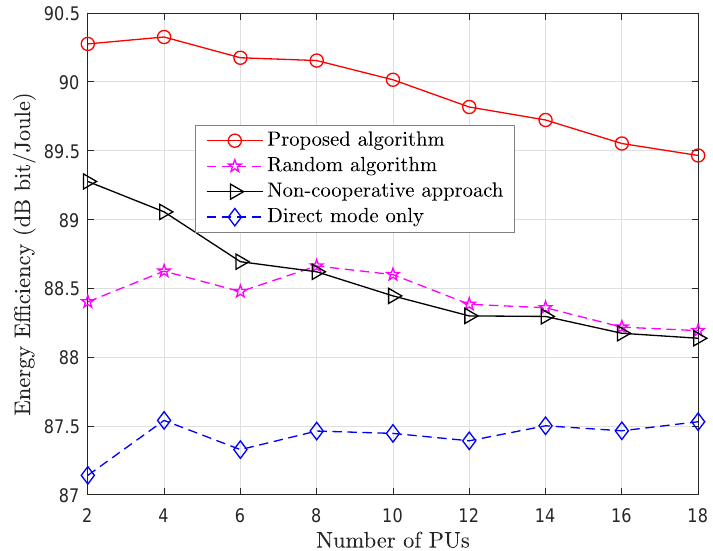
Figure 5. Energy efficiency varying number of PUs. M varies from 2 to 18 and K =